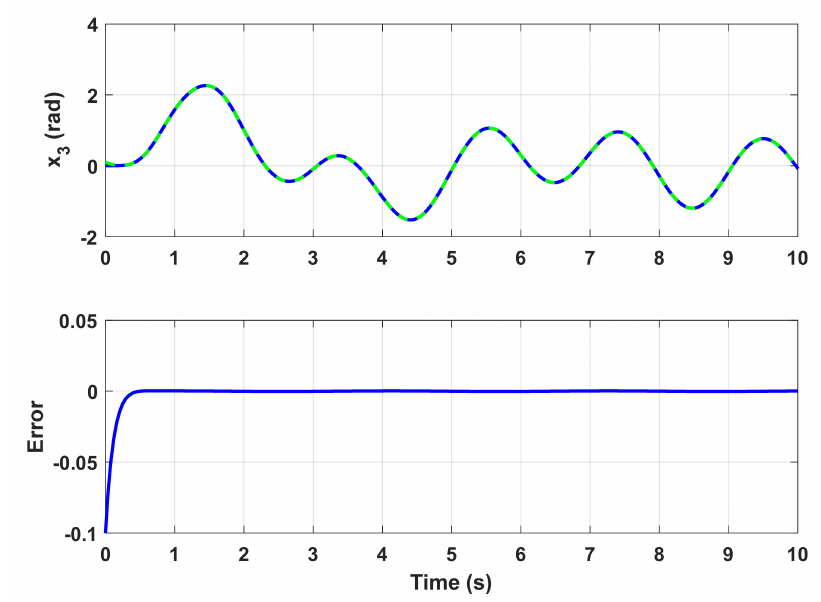
Figure 7. Estimation and error of arm angle.